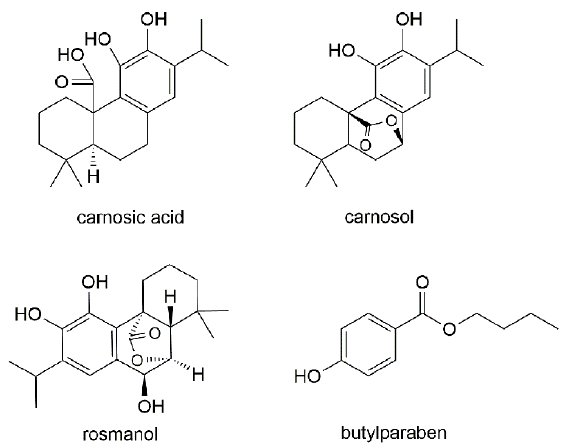
Figure 1. The chemical structures of the three analytes and I.S.